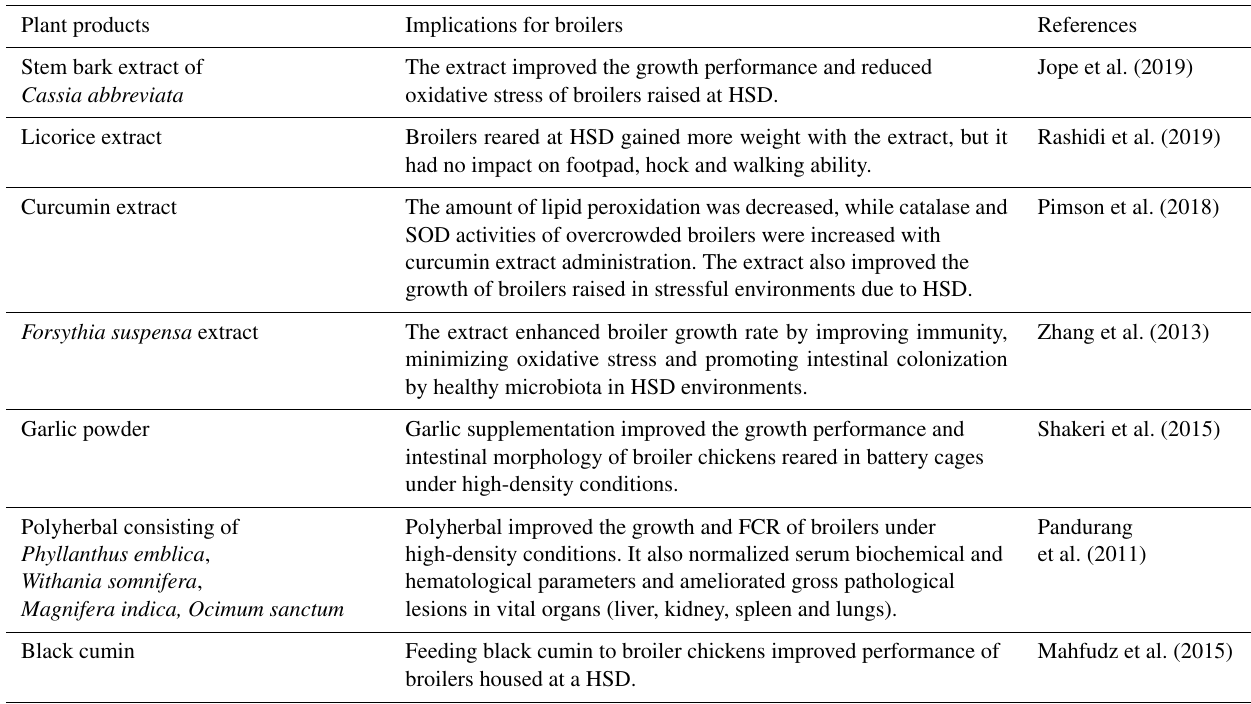
Table 3. The use of plant-derived products in broilers raised at a high stocking density. Plant products Implications for